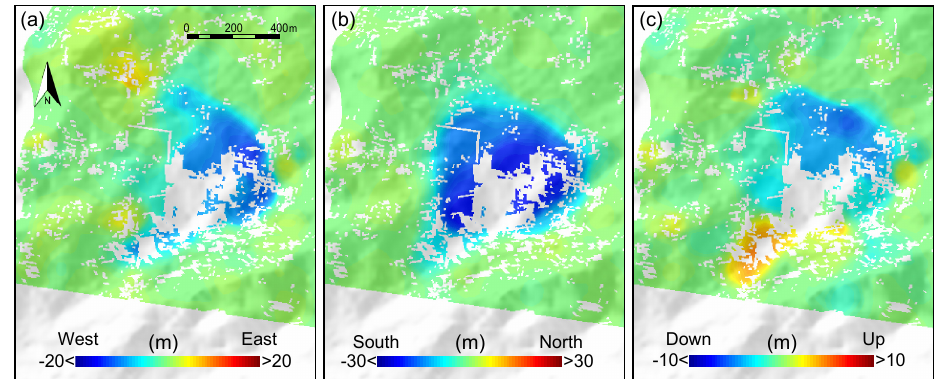
Figure 2. The new Montescaglioso landslide of 3 December 2013. Pixel-offset results for the (a) east–west, (b) north–south, and (c) up– down components of the surface deformation. Measurements are the results of the combination of pixel-offset results obtained processing COSMO-SkyMed images acquired along ascending and descending